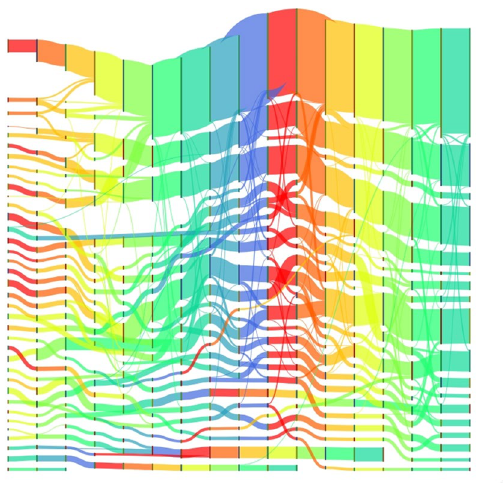
Figure 10. Evolution of teams over time for the NECTEC researchers network. Nodes represent communities at a certain time t , size represent team size. Edges represents researchers moving from one community at time t to another community at time t + 1 . Edge thickness represents the number of researchers. Colors represent different time transitions. Only communities of size 5 or greater are